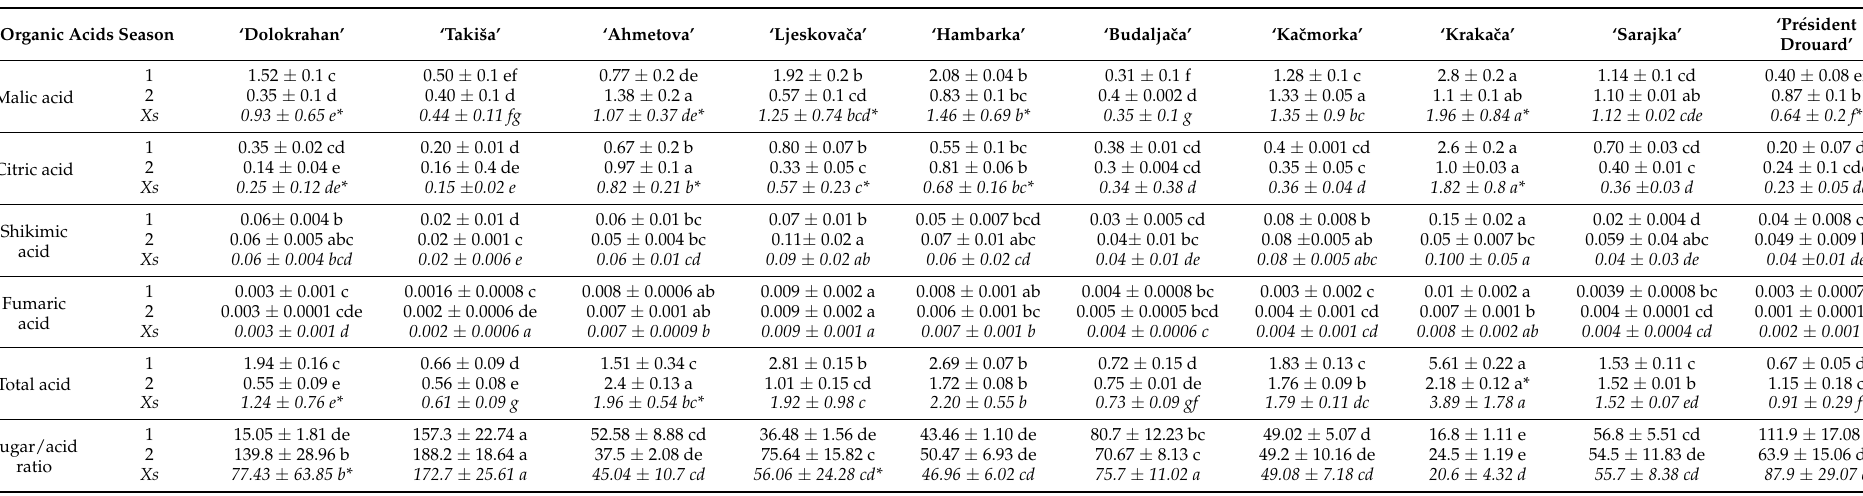
Table 3. Average content of individual organic acids, total acids (TA), and sugars/acids ratio (S/A) in analyzed pear cultivars (g kg − 1 ) FW*. Organic Acids Season ‘Dolokrahan’ ‘Takiša’ ‘Ahmetova’ ‘Ljeskovaˇca’ ‘Hambarka’ ‘Budaljaˇca’ ‘Kaˇcmorka’ ‘Krakaˇca’ ‘Sarajka’ ‘Pr